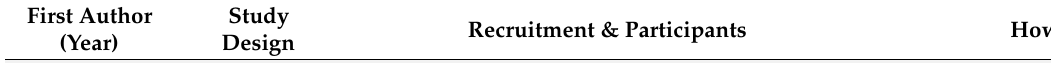
Table 2. Primary Research Targeting Diet at Christmas and New